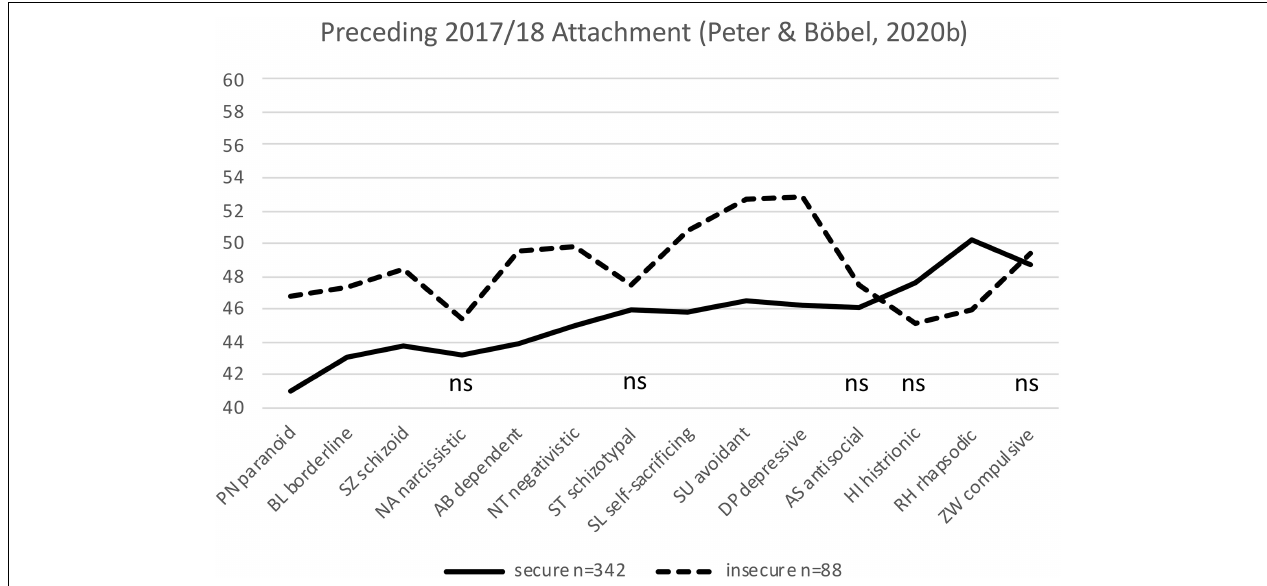
FIGURE 1 | Significant differences in the preceding reference study by Peter and Böbel (2020b) between 342 securely and 88 insecurely attached psychological psychotherapists in nine of 14 personality styles. The non-significant differences are labeled ns ( t -values are plotted on the y -axis; mean is t = 50; normal range is between t = 40 and t = 60; ns: not significant).